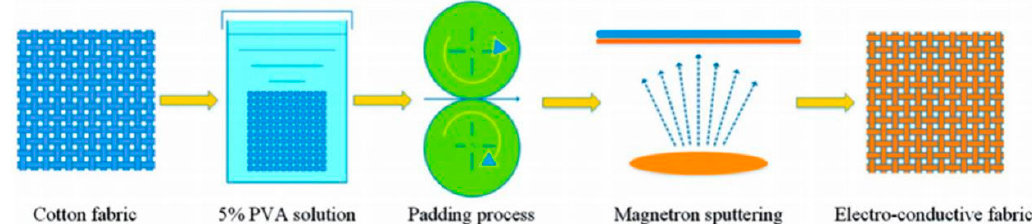
Figure 3. Schematic of the preparation of PVA impregnated cotton fabric by padding and sputtering. (Reprinted from Reference [43] with permission).